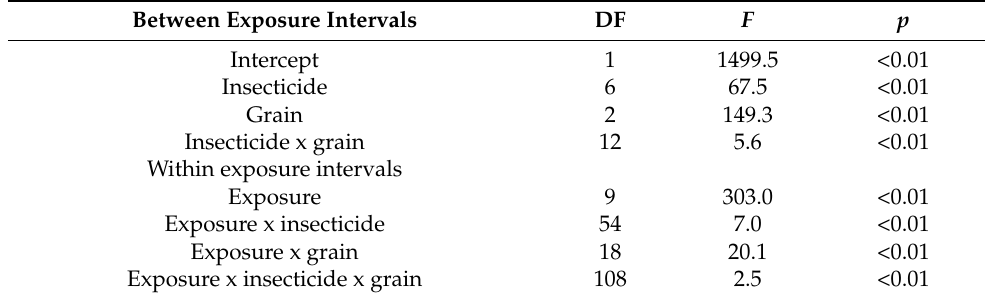
Table 1. MANOVA parameters for the main effects and associated interactions leading to the observed mortality rates of Sitophilus oryzae adults between and within exposure intervals (error DF = 168). Between Exposure Intervals DF F p Intercept 1 1499.5 <0.01 Insecticide 6 67.5 <0.01 Grain 2 149.3 <0.01 Insecticide x grain 12 5.6 <0.01 Within exposure intervals Exposure 9 303.0 <0.01 Exposure x insecticide 54 7.0 <0.01 Exposure x grain 18 20.1 <0.01 Exposure x insecticide x grain 108 2.5